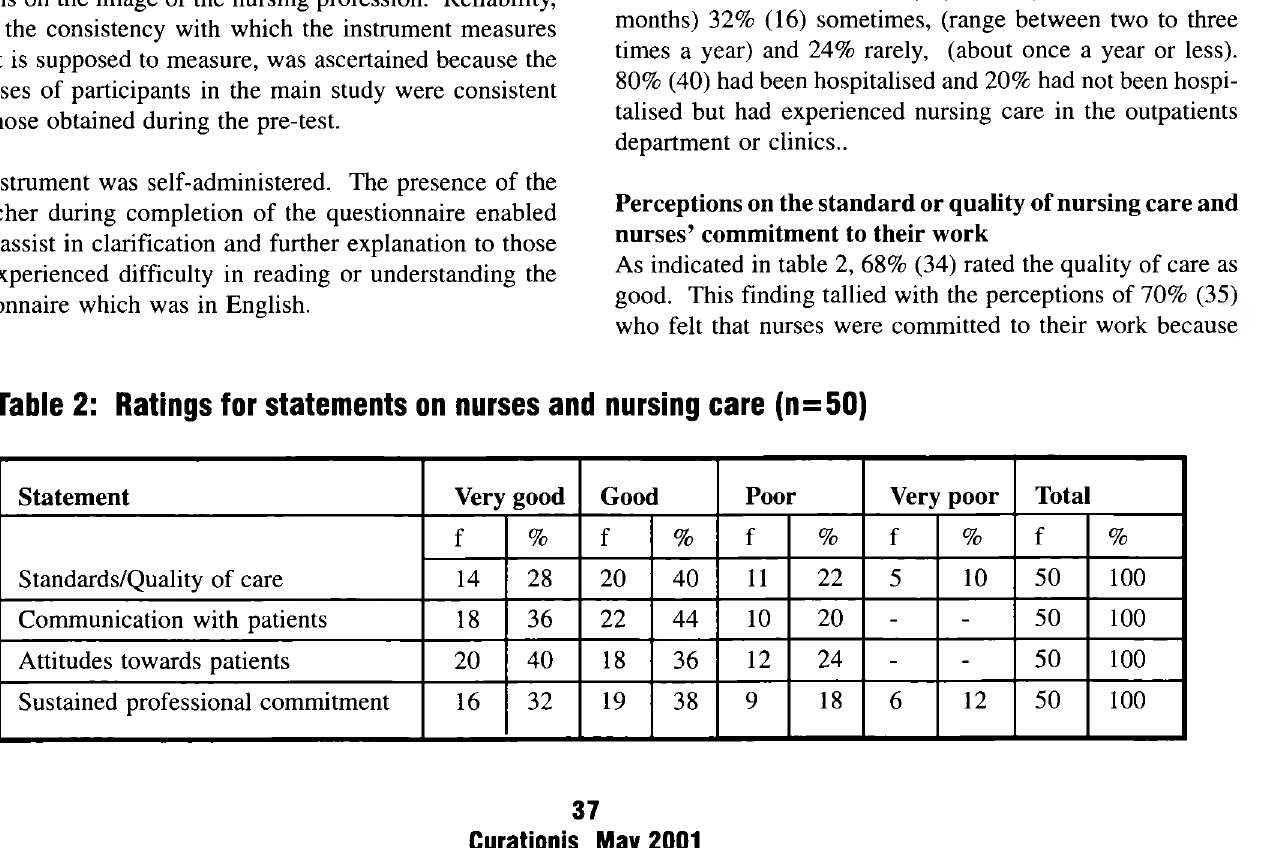
Table 2: Ratings for statements on nurses and nursing care